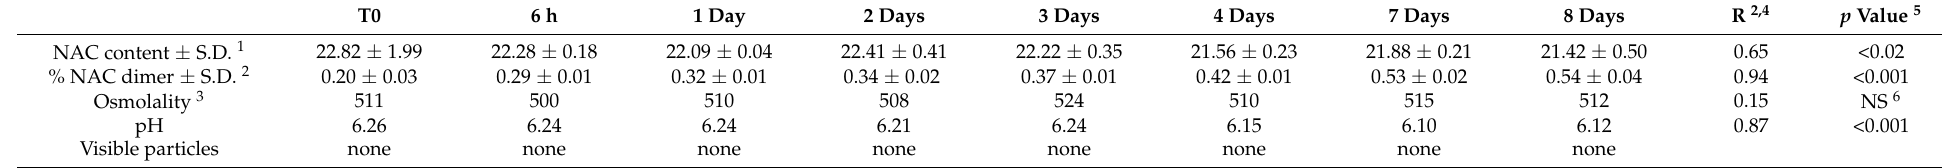
Table 4. NAC stability study, 5 ± 3 ◦ C storage conditions.